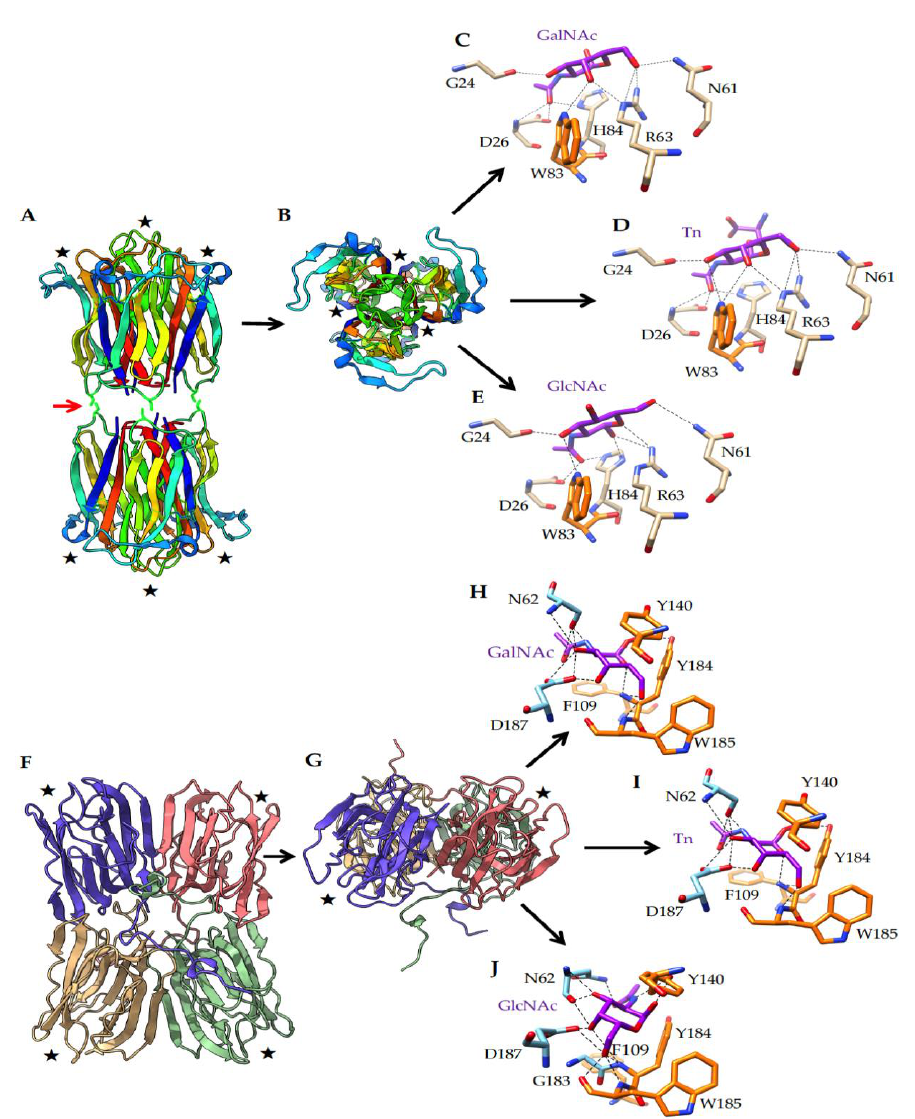
antibodies or ( B , C ) with FITC-lectins: HPA (FITC-HPA), MorG (FITC-MorG), or ConA (FITC-ConA). ( A ) Red arrow indicates autofluorescence pic position (grey curve); ( B ) representa- tive results of two independent experiments with 5 μ g/mL of labeled lectin, with blue curve cor- responding to neuraminidase-treated cells; and ( C ) lectin concentration effect on labelling. ( D ) EL4 cells were incubated with (+ Nase) or without ( − Nase) neuraminidase, washed, and cultured for 48 h with 2.5 μ g/mL of HPA, MorG, or ConA, then cell death was analyzed using cytofluorimetry. Results are means ± SD of three independent experiments.